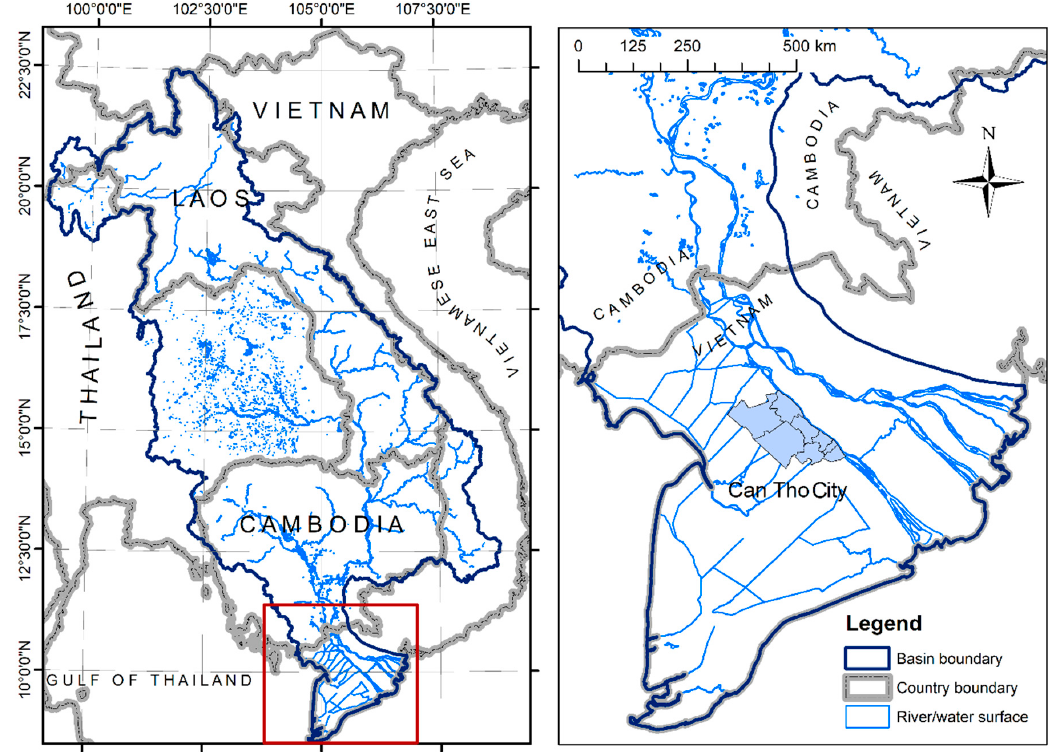
Figure 1. Lower Mekong Basin ( left figure ) in South-East Asia; Study Area Can Tho City (highlighted in the right figure ).